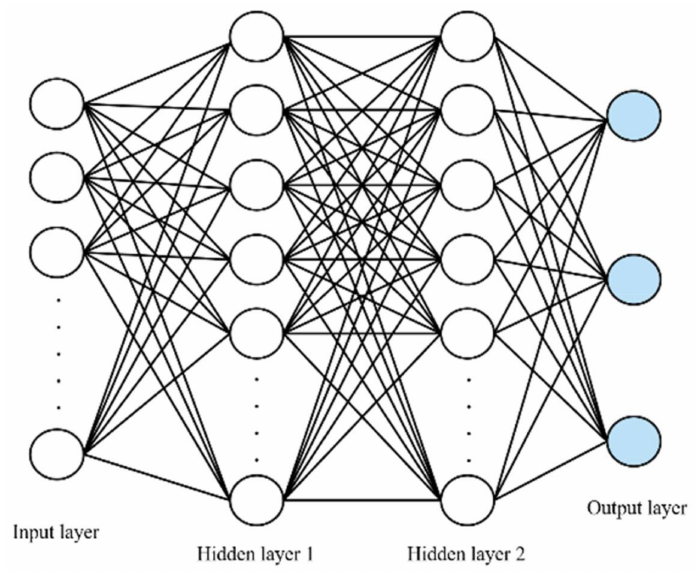
Figure 4. Structure of an